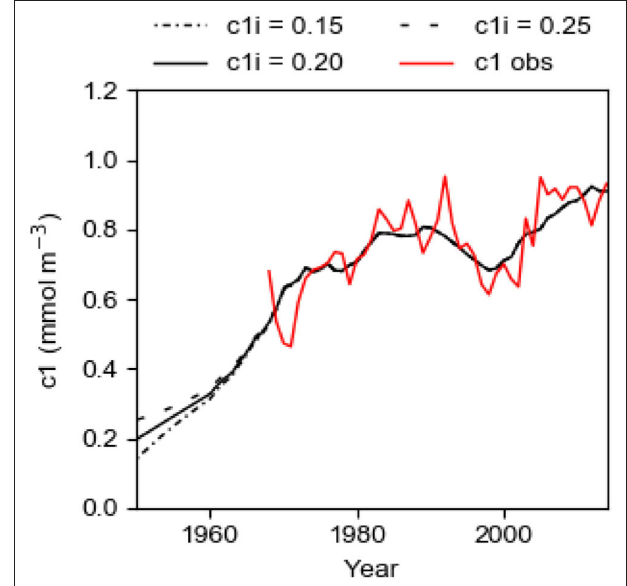
FIGURE 7 | Model results showing the normalized sum of the squared residual Ssr ( TRVF , fs ), see Equation (12), in the parameter space 1,800 ≤ TRVF ≤ 5,000, 0 ≤ fs ≤ 3. The least value of Ssr ( TRVF , fs ) occurs for TRVF = 3,000 km 3 year − 1 and fs = 1.22 tons km − 2 year − 1 .